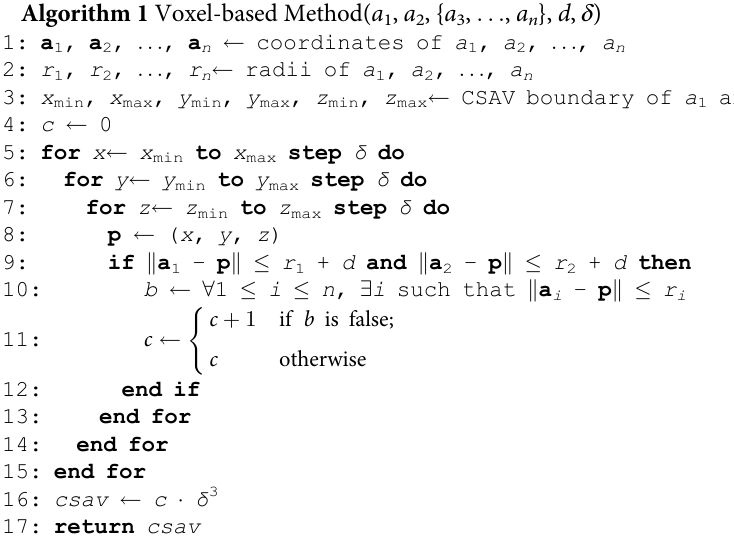
, a , { a , . . . , a }, d , δ 1 2 3 n